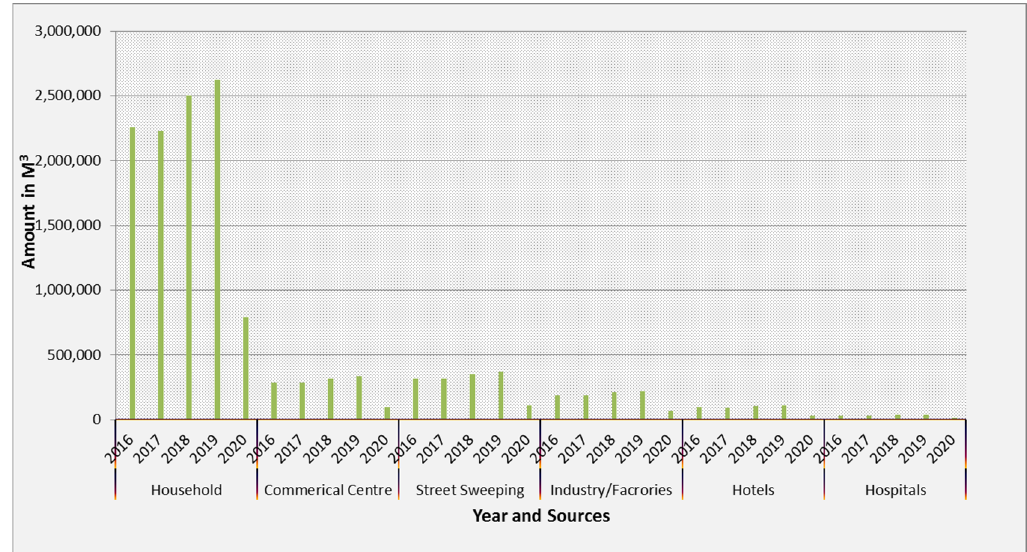
Figure 2. The generation of solid waste in Addis Ababa (2016–2020) (M 3 ).